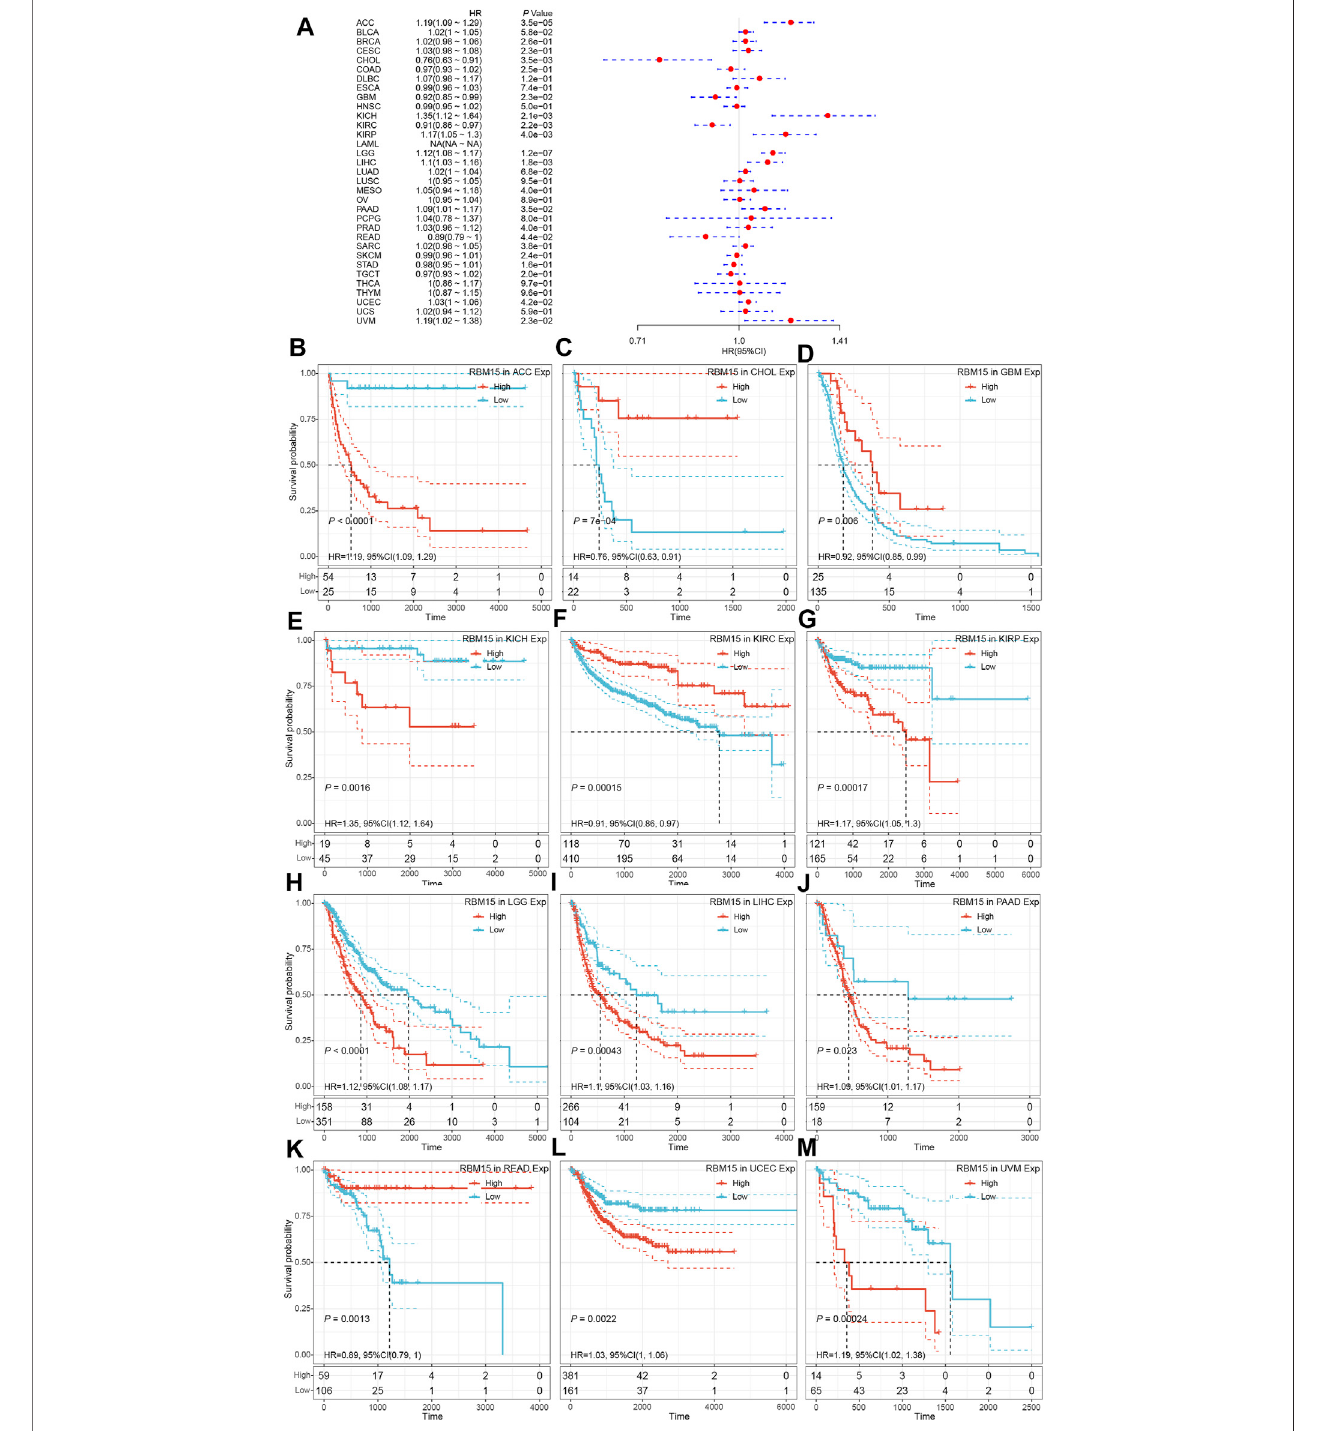
FIGURE 5 | RBM15 expression is correlated with patient ’ PFI. (A) Forest plots of HR for RBM15 expression in 33 tumor types. (B – M) Kaplan-Meier curves of signi fi cant correlation between RBM15 expression levels and patient ’ PFI in ACC, CHOL, GBM, KICH, KIRC, KIRP, LGG, LIHC, PAAD, READ, UCEC and UVM.